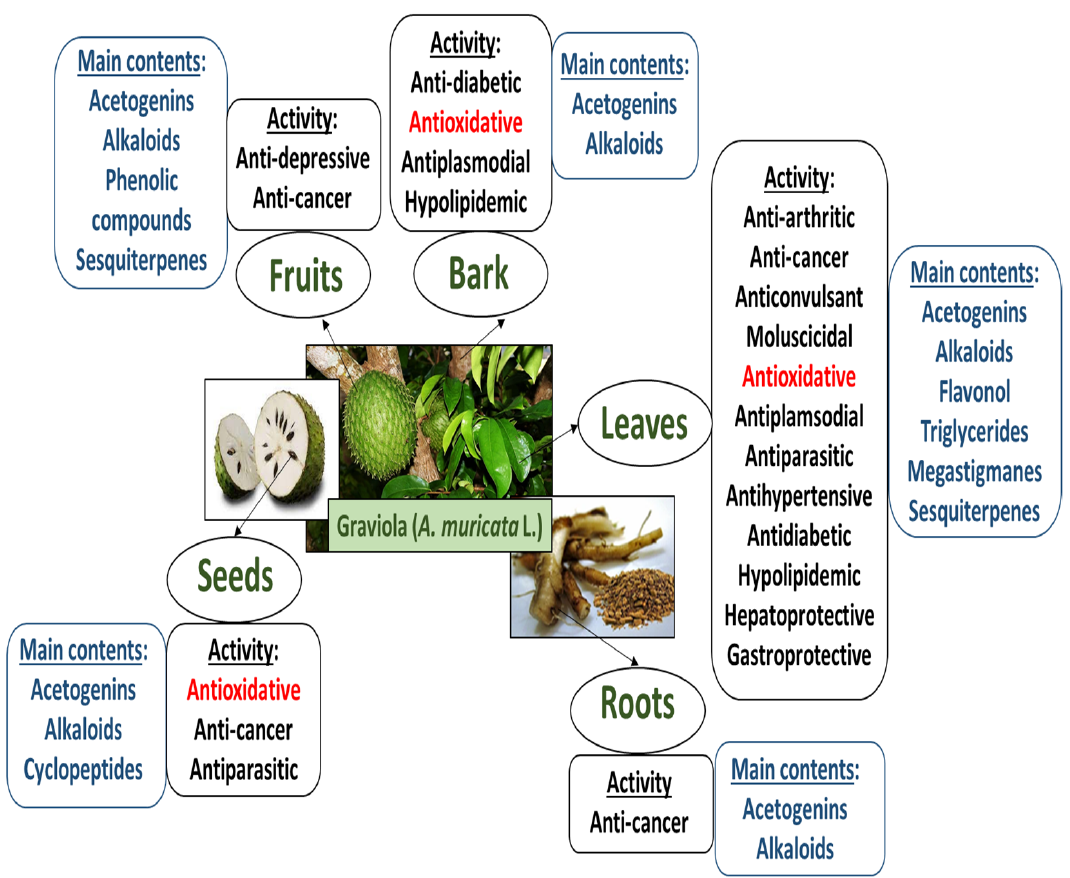
Figure 2. Main contents and main biological properties of various parts of graviola (adapted from ref.: Moghadamtousi et al. [2]).